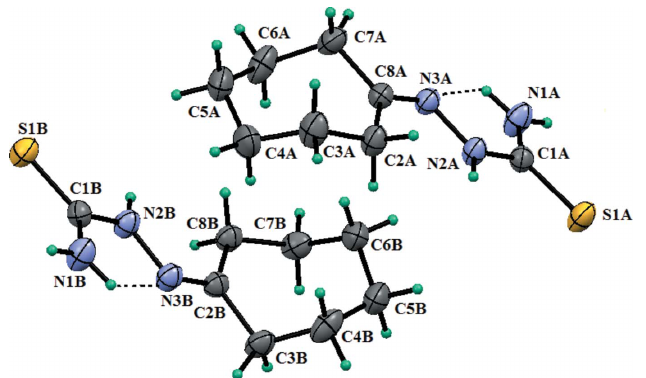
Figure 1 The molecular structure of the title compound, with displacement ellipsoids drawn at the 40% probability level. H atoms are shown as small spheres of arbitrary